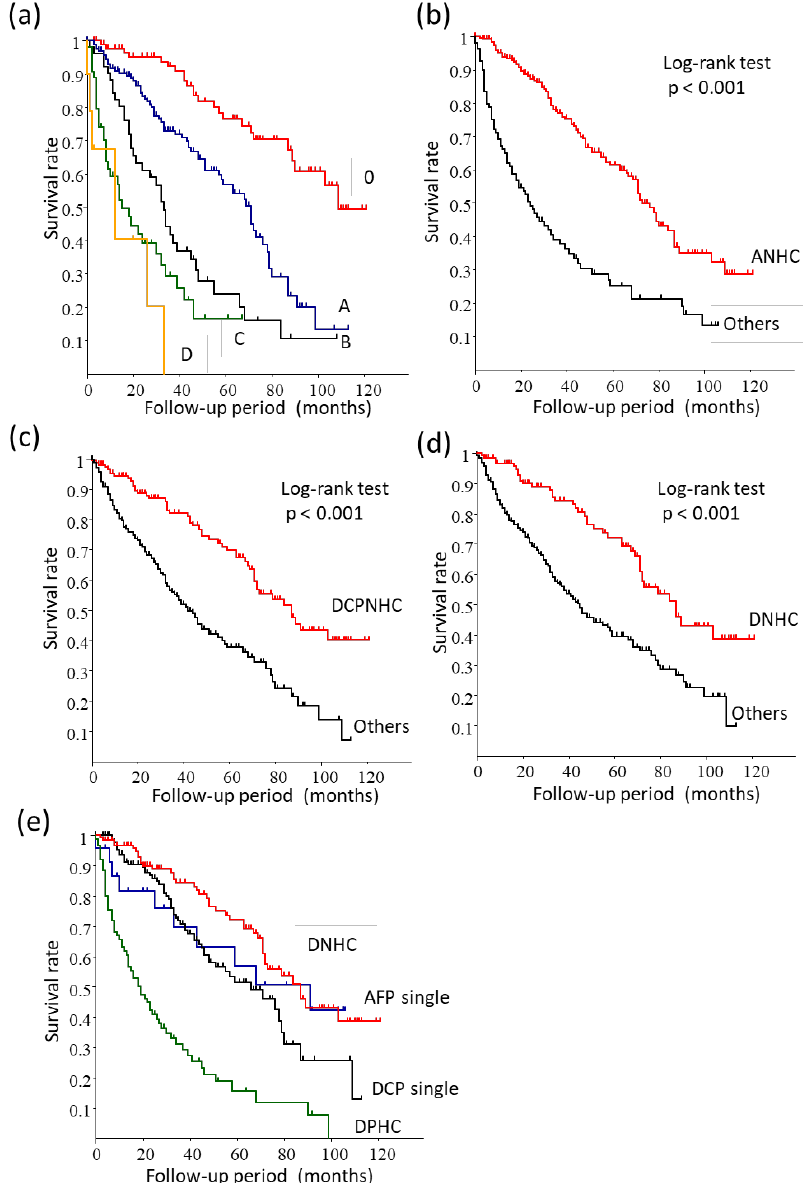
Figure 4. Survival analysis. ( a ) BCLC staging for all patients. It was well stratified (inter-group statistical differences are p < 0.001, except for B vs. C; p = 0.022, B vs. C; p = 0.028, B vs. D; p = 0.005, and C vs. D; n.s.). ( b ) Comparison between ANHC and the other patient groups. The survival rate of the patients with ANHC was significantly better than the other patients ( p < 0.001). ( c ) Comparison of DPCNHC and the other patient groups. The survival rate of the patients with DCPNHC was signif- icantly better than the other patients ( p < 0.001). ( d ) Comparison between DNHC and the other pa- tients. The survival rate of the patients with DNHC was significantly better than the other patients ( p < 0.001). ( e ) There was no difference between DNHC and AFP single-positive cases. DNHC cases demonstrated a substantially better prognosis than DCP single-positive cases ( p < 0.001) and DPHC cases ( p < 0.001). In higher-stage HCC (BCLC-B, C, and D), the MST of the patients with ANHC was significantly better than the other groups [39.0 (32.0 – 55.0) vs. 14.0 (8.0 – 19.0) months, re- spectively, p < 0.001) (Figure 5a). The MST of the patients with DCPNHC was not statisti- cally different from the other patient groups [42.0 (19.0 – 55.0) vs. 20.0 (14.0 – 30.0) months, respectively, p = 0.087) (Figure 5b). The MST of the patients with DNHC was significantly better than the other groups [47.0 (24.0 – 84.0) vs. 19.0 (14.0 – 30.0) months, respectively, p =